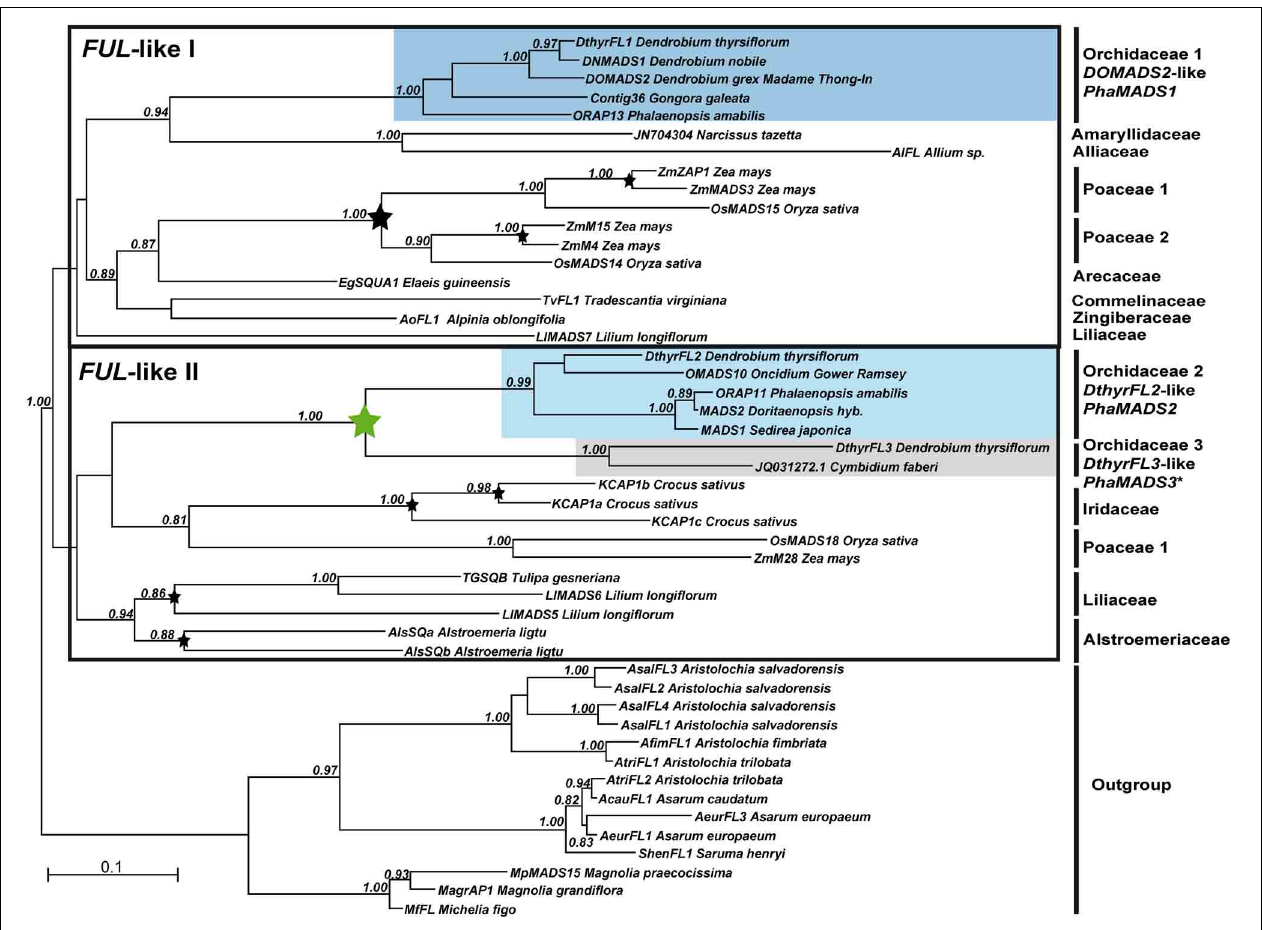
FIGURE 2 | Maximum Likelihood phylogeny of monocot FUL -like genes. The two major monocot clades previously identified are indicated with a black frame (Litt and Irish, 2003). The clades containing sequences from Orchidaceae are highlighted if gene expression was characterized in Phalaenopsis hyb. “Athens.” Otherwise the non-isolated ortholog is marked